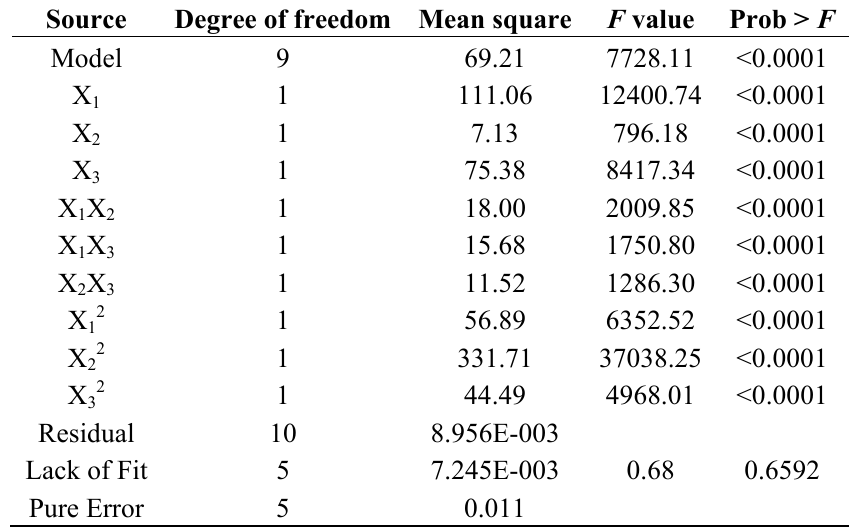
Table 2. Model-fitting results and analysis of variance for the TAG purity a .